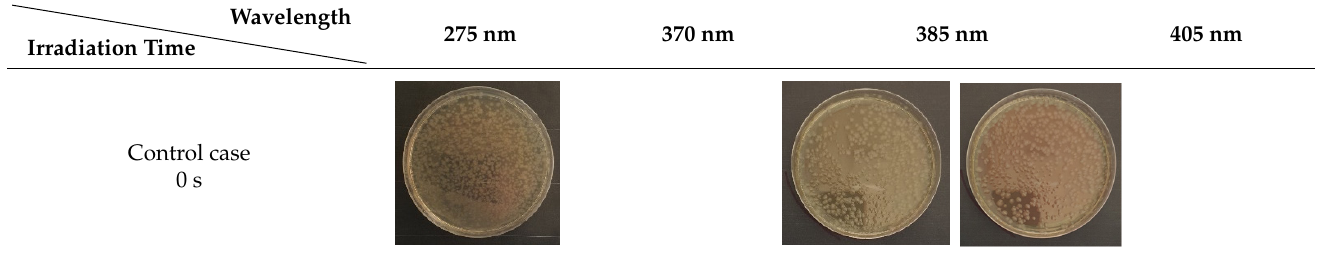
Figure 5. Inactivation curves of E. coli at each dose and wavelength: ( a ) 370, 385, and 405 nm; ( b ) 275 nm. Table 5. Numbers of E. coli colonies by wavelength and irradiation time.